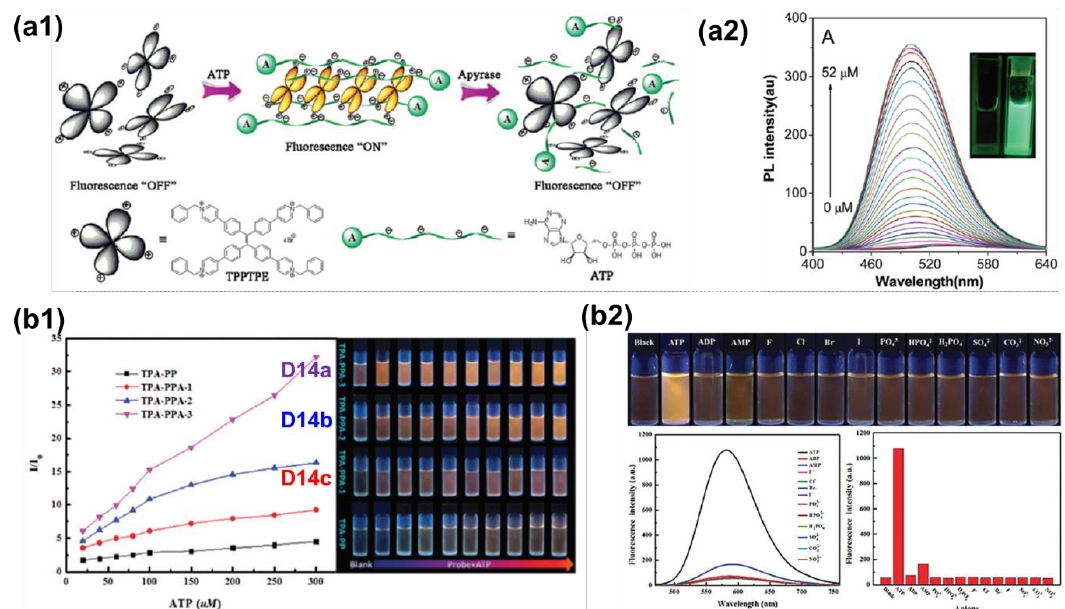
Figure 10. ( a1 ) Schematic showing the binding of D13 with ATP, and ( a2 ) spectrofluorometric titration studies of D13 with ATP. Insert: photos showing the turn-on of green emission of D13 due to ATP. ( b1 ) Plot of maximum emission intensities of D14a – D14c (vs. a control compound without boronic acid groups), with an increasing amount of ATP added; on the right, photos showing the corresponding emission changes. ( b2 ) Fluorescence spectra and photos showing emission turn-on for D14a due to selective recognition of ATP. Reproduced with permission from [112] and [113]. Copyright 2017, the Royal Society of